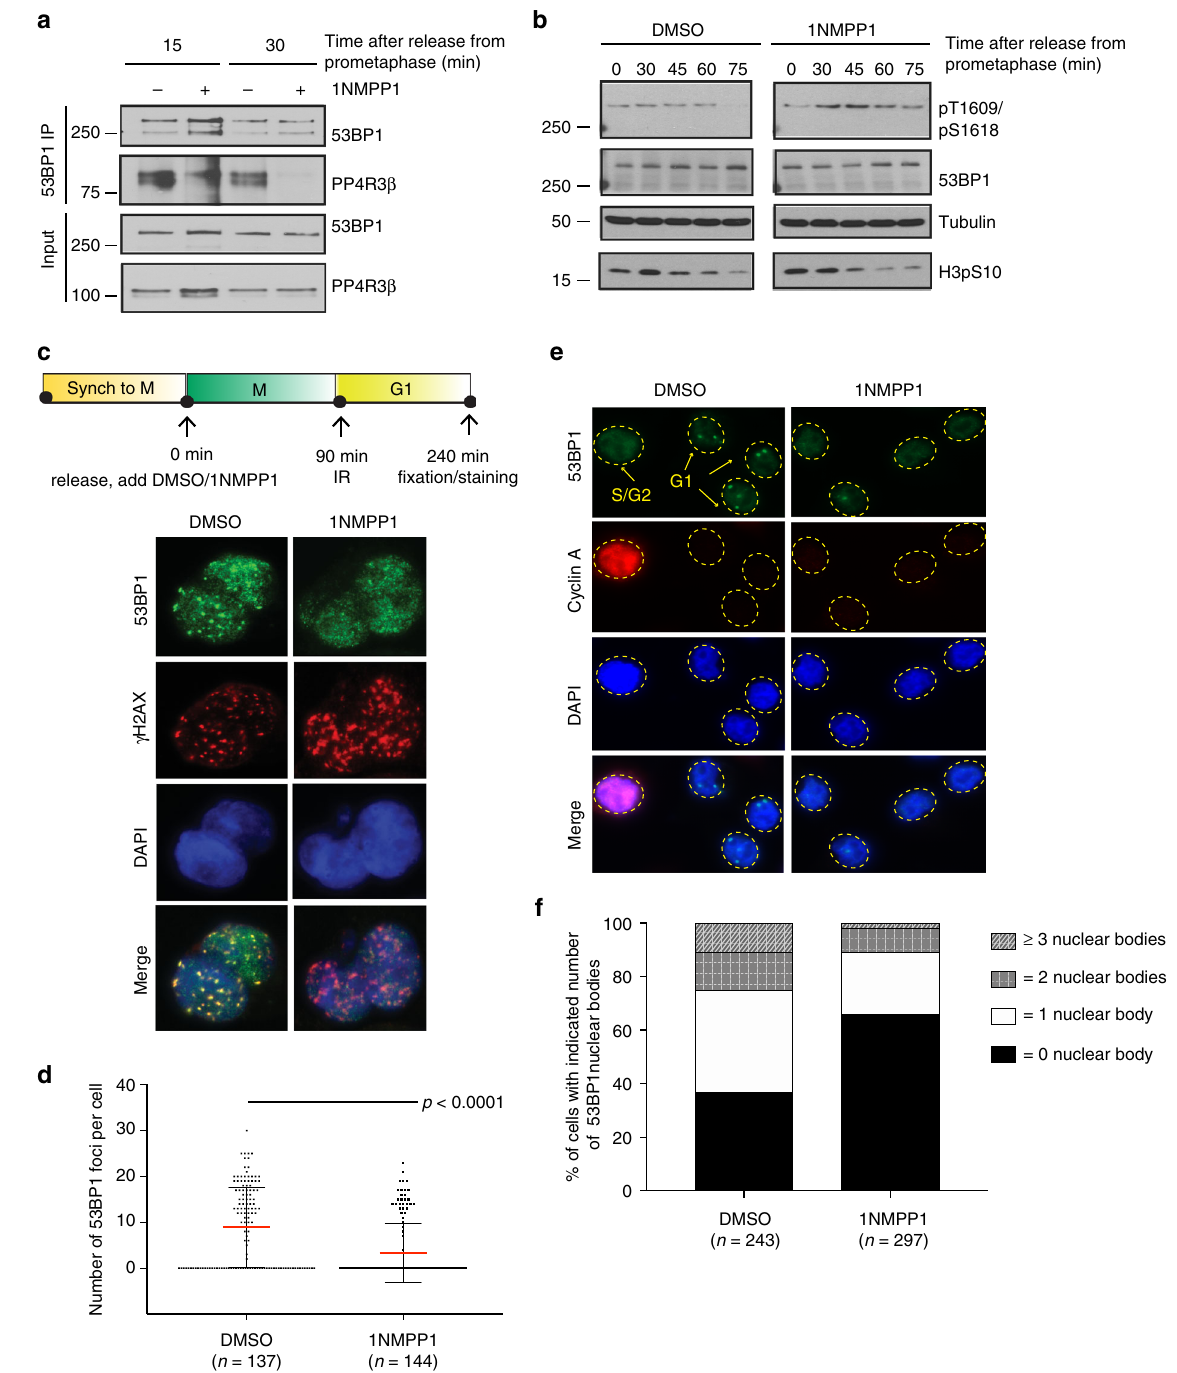
Fig. 4 CDK5 regulates dephosphorylation and the recruitment of 53BP1 to DNA damage. a Endogenous 53BP1 was immunoprecipitated from DMSO- treated or 1NMPP1-treated A375-AS cells and collected at indicated time points after release from arrest at prometaphase. Levels of co- immunoprecipitated endogenous PP4R3 β were analyzed by immunoblot. b Endogenous 53BP1 was immunoprecipitated from DMSO-treated or 1NMPP1- treated A375-AS cells, collected at indicated time points, after release from nocodazole-induced arrest at prometaphase. Levels of 53BP1 T1609/s1618 phosphorylation from immunoprecipitated endogenous 53BP1 were analyzed by immunoblot. c Mitotic A375-AS cells, collected by shake-off from arrest at prometaphase, were immediately treated with DMSO or 10 µ M of 1NMPP1 and seeded on poly-D-lysine-coated coverslips. 90 min after release, treated cells were irradiated with 5 Gy. 240 min after release, cells were fi xed and stained with indicated antibodies to detect irradiation-induced 53BP1 foci. γ - H2AX was stained to mark sites of DNA damage. d Quanti fi cations of 53BP1 foci in c , pooled from triplicate repeat experiments, expressed as mean ± s.d. Total number of cells is indicated in parenthesis. P -values, Mann – Whitney U Test. e A375-AS cells were exposed to 0.2 µ M Aphidicolin and DMSO or 10 µ M 1NMPP1 for 12 h. Cells were fi xed and stained for 53BP1 and Cyclin-A, a negative marker for G1 cells. f Quanti fi cation of percentage of cells containing 53BP1-containing nuclear bodies in e out of total cells, indicated in parenthesis, pooled from triplicate repeat experiments. P